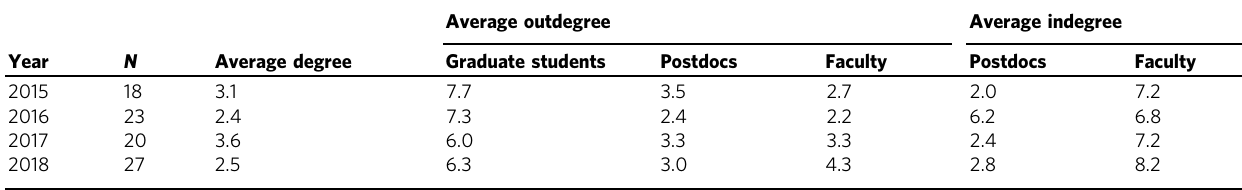
Table 1 Mentoring network metrics.